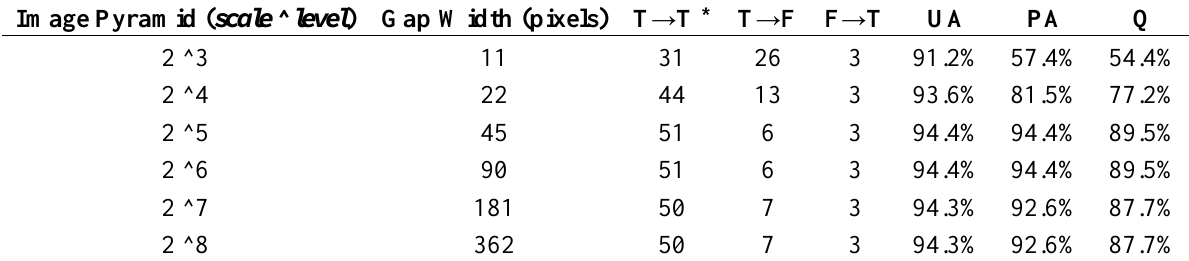
Table 3. The sensitivity of gap width ( Tg ) in